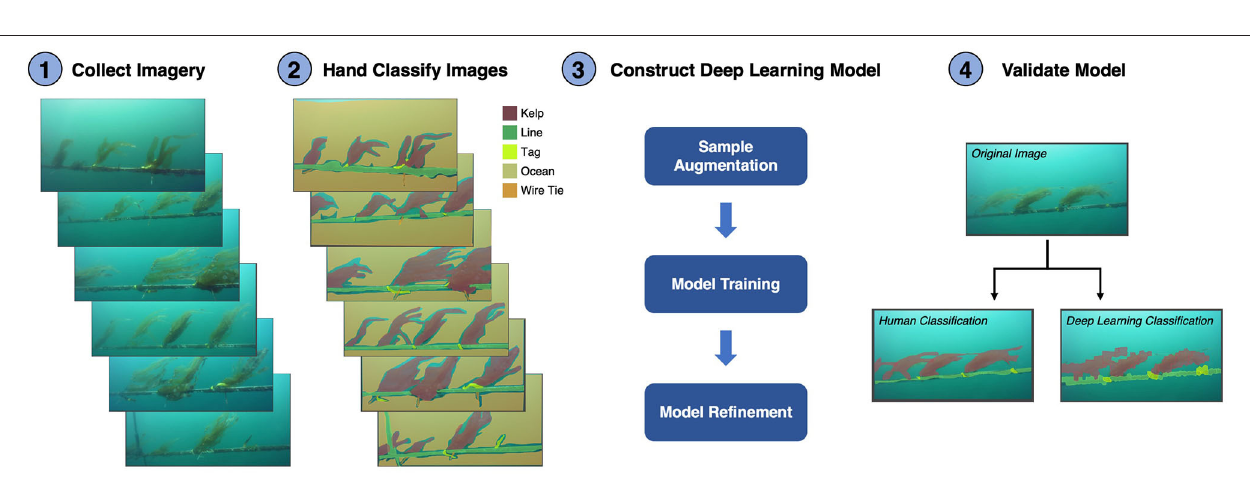
FIGURE 6 | Schematic showing the steps to develop and validate the deep learning model used to automatically classify giant kelp juveniles on an aquaculture farm. (1) Collect imagery of the farm lines using a color camera mounted on an underwater vehicle. (2) The images ( n = 137) were classified by hand into five classes: Kelp, Line, Tag, Ocean, and Wire Tie. Light blue areas show sections of the background ocean which were not classified by hand. (3) The number of samples for model training was augmented by extracting multiple samples from inside the polygons of each class. The model was then trained using 60% of the images with a convolutional neural network and refined using 20% of the images. Model refinement involves identifying and removing poorly performing classes. (4) The final model was validated using the final 20% of the imagery by comparing hand classifications to the deep learning